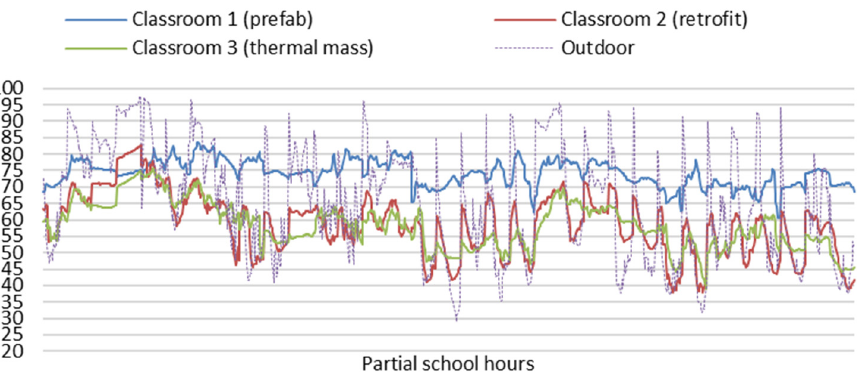
Figure 7. Field study data of indoor relative humidity of the three classrooms during school hours (8:30 a.m. to 3:30